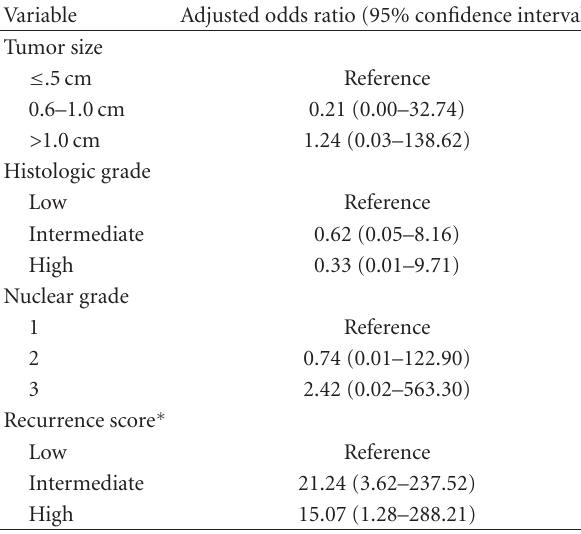
Table 2: Logistic regression for uptake of adjuvant chemotherapy ( n =